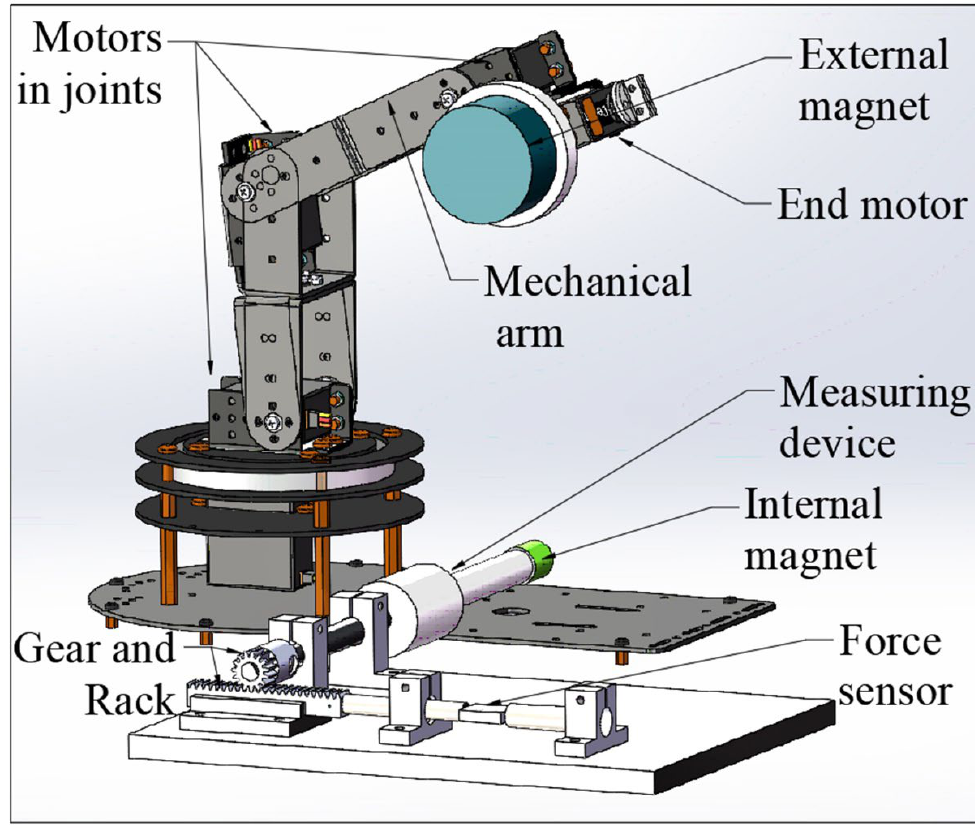
Figure 3. Magnetic torque measuring system.